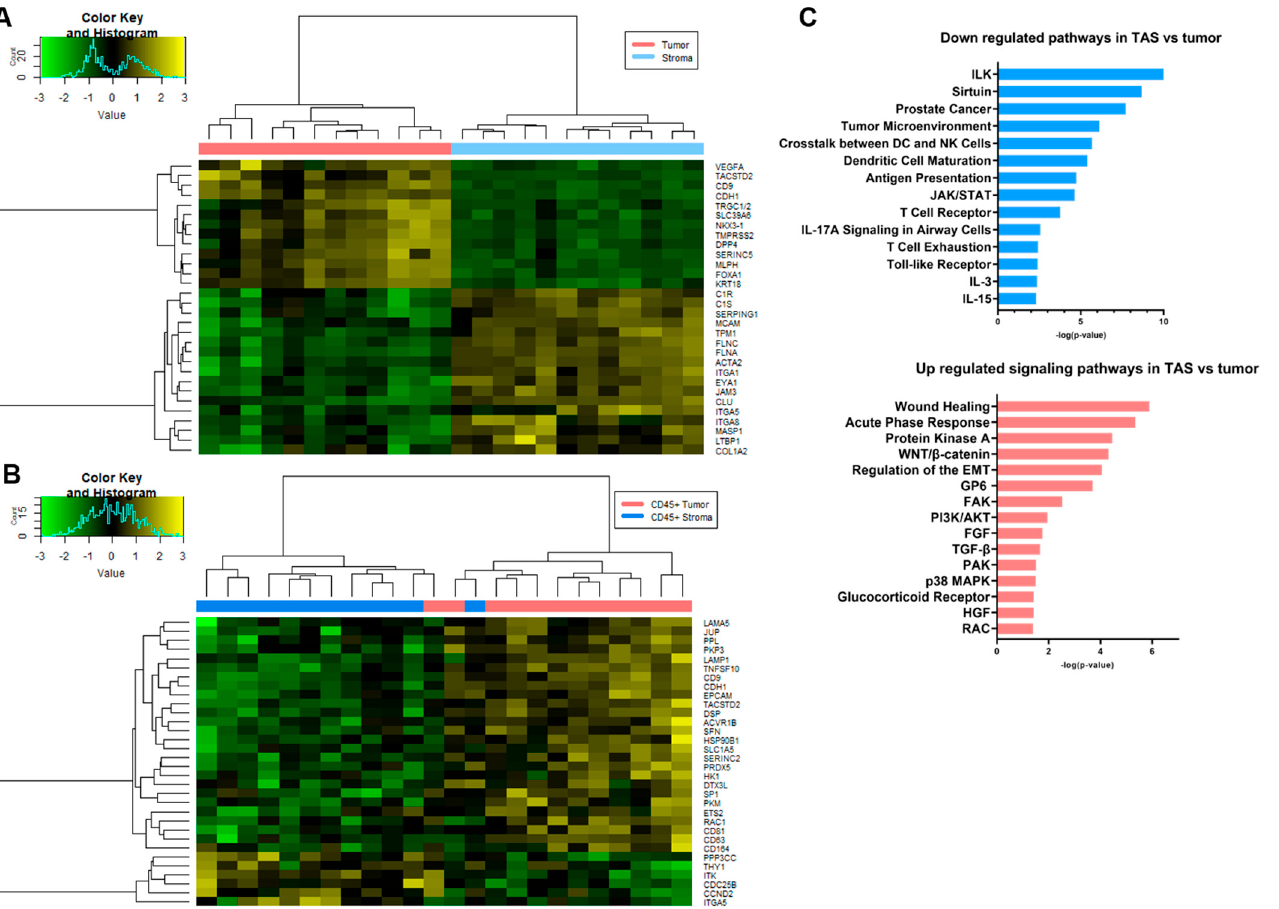
Figure 5. Spatial transcriptomic analysis of tumor-adjacent stroma and tumor. Heatmaps generated using the normalized expression values for genes from the Cancer Transcriptome Atlas, CTA panel for comparisons between ( A ) tumor epithelium and tumor-adjacent stroma and ( B ) CD45+ tumor epithelium and CD45+ tumor-adjacent stroma. The most significant genes (FDR < 0.2 and p -value < 0.05) that were differentially expressed among pairs of ROIs are shown. ( C ) Bar diagrams depicting selected significant pathways ( p < 0.05) associated with downregulated genes and selected significant pathways ( p < 0.05) associated with upregulated genes in TAS as compared to tumor. Complete pathway analysis can be found in Supplementary Table S6a,b FDR = false discover rate; ROI = region of interest; TAS = tumor-adjacent stroma.